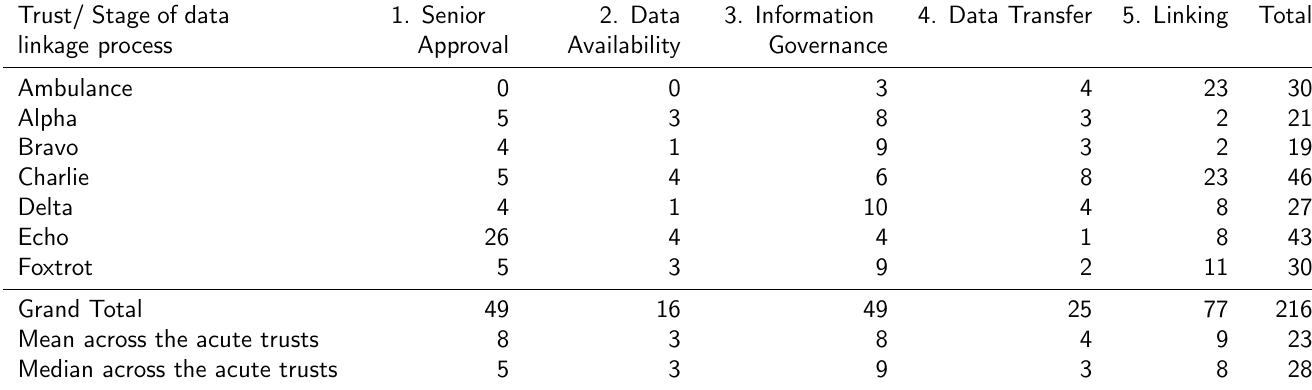
Table 1: Research team’s time (to the nearest hour) to complete each step of successful data linkage, by Trust Trust/ Stage of data